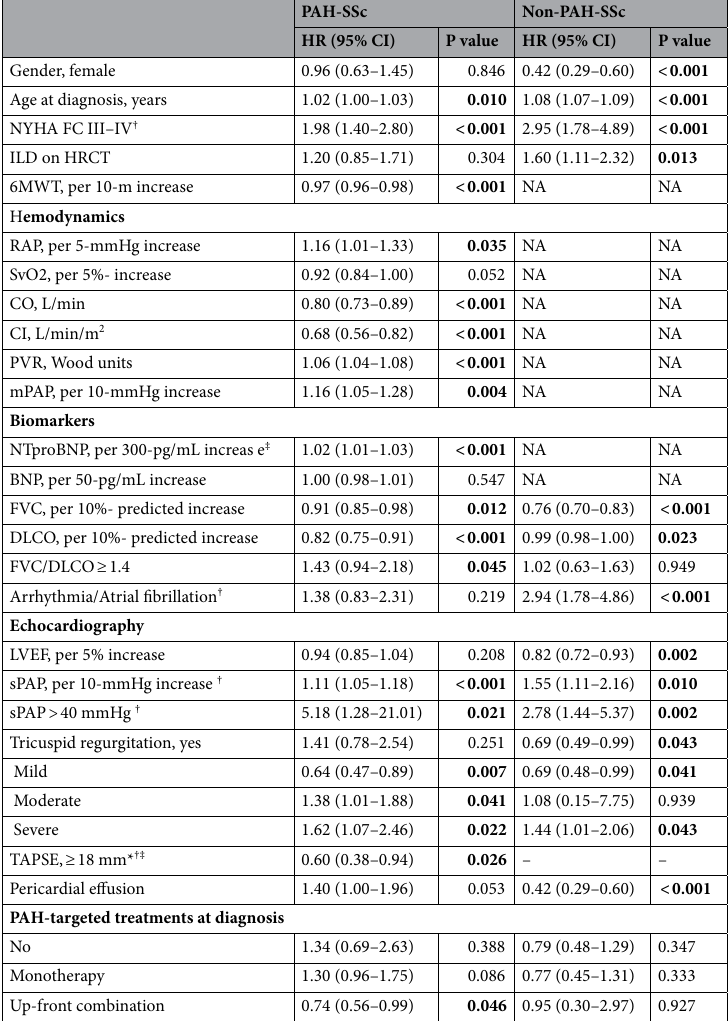
Table 3. Factors associated to survival in univariate analyses. Significant values are in bold. † Parameter not included in the multivariate analysis as it was available in less than 60% of non-PAH-SSc patients. ‡ Parameter not included in the multivariate analysis as it was available in less than 60% of PAH-SSc patients. *All death patients in non-PAH-SSc had TAPSE ≥ 18 mm.